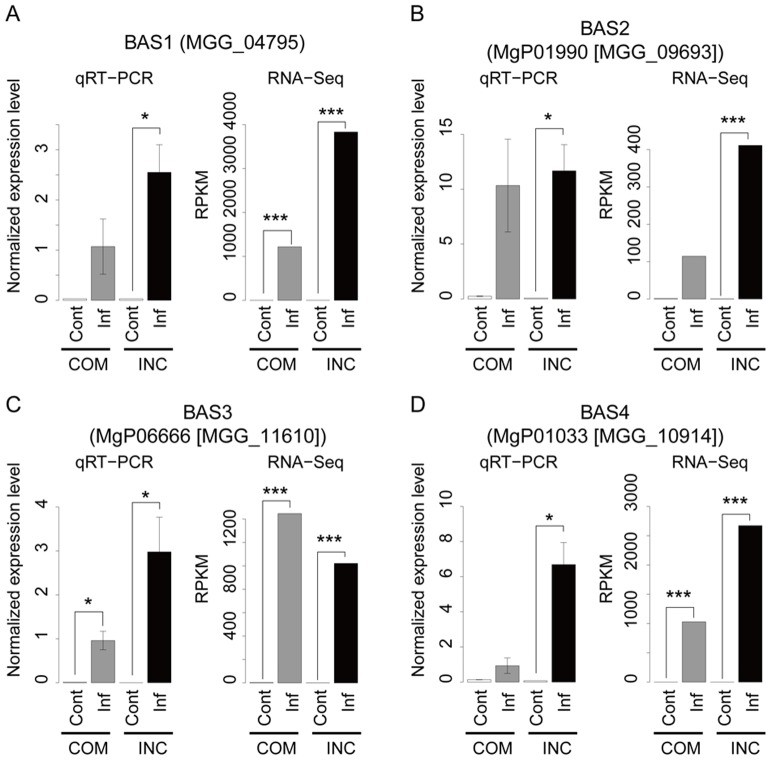
Confirmation of differential expression of known infection-responsive fungal genes by qRT-PCR and RNA-Seq.The expression profiles of known infection-responsive fungal genes, biotrophy-associated secreted (BAS) proteins (A) 1, (B) 2, (C) 3 and (D) 4, were examined by both qRT-PCR and RNA-Seq techniques. For the qRT-PCR data, the mean±standard errors for the three replicates are represented. The statistically significant differential gene expression between the control (Cont) and infected (Inf) samples for the compatible (COM) and incompatible (INC) interactions were tested by the Student's t-test and G-test for qRT-PRC and RNA-Seq, respectively. The asterisks show the statistical significances (*: P<0.05, **:P <0.01 and ***: P<0.001).